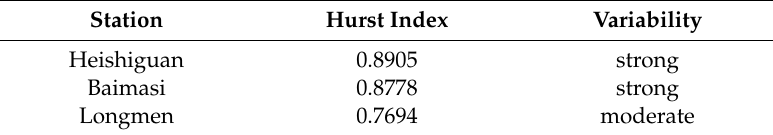
Table 1. Hurst index and variability.